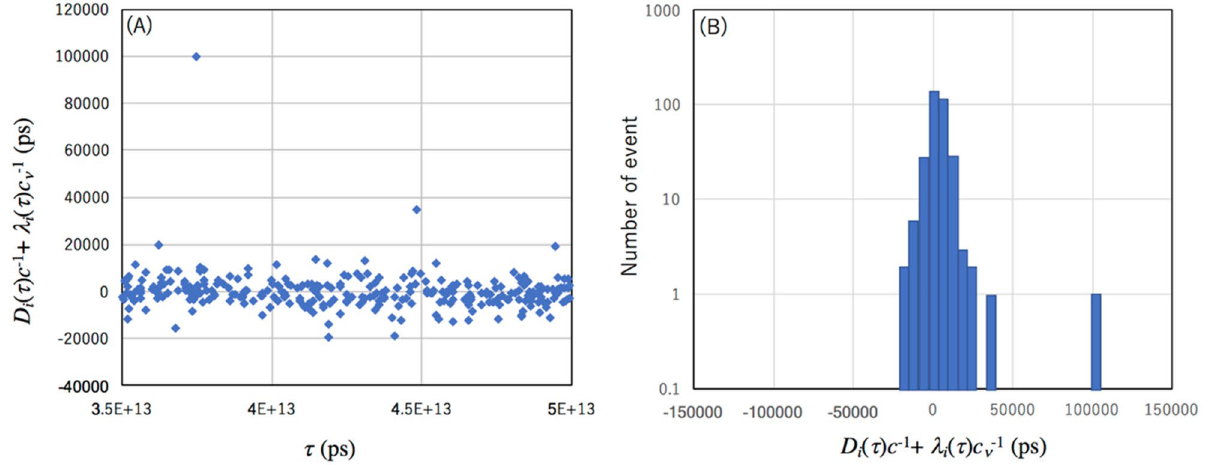
Figure 6. Plot where the artificial drift is subtracted from the data and its distribution. The data corresponds to Fig. 5D ( A ) and the distribution is shown in a logarithmic scale ( B